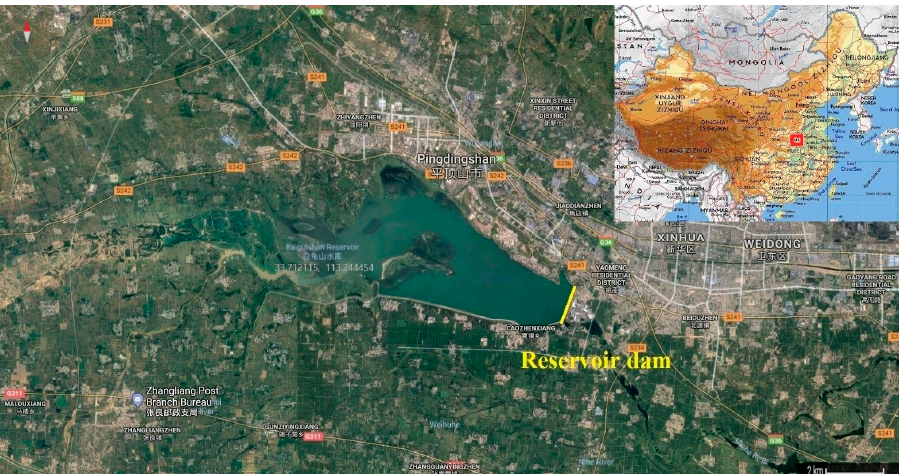
Figure 1. Geographical location of the Baiguishan reservoir dam.